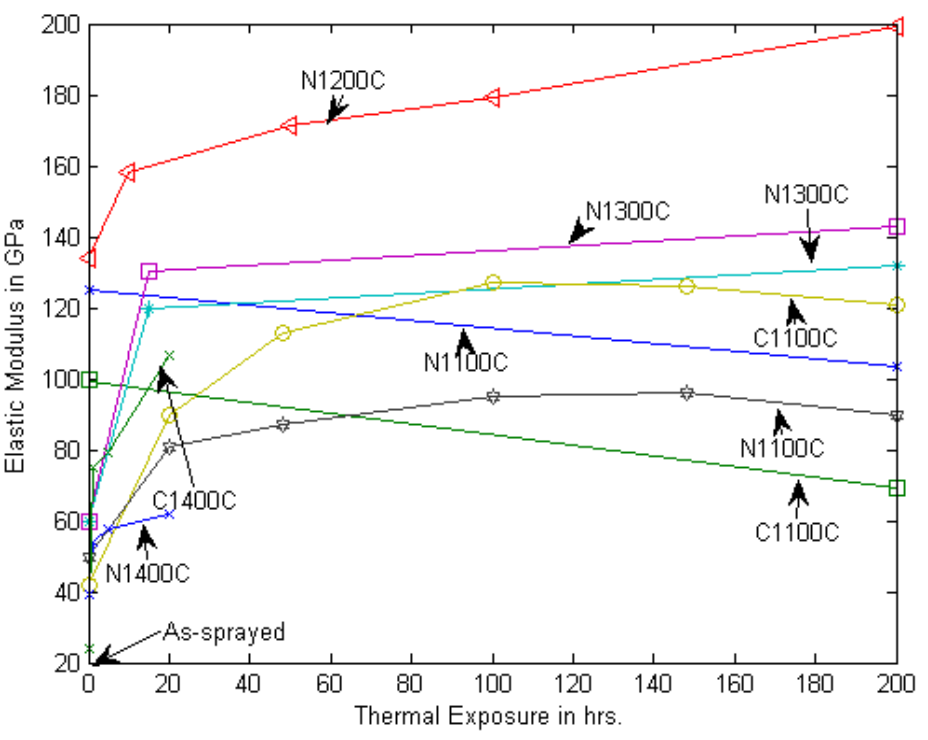
Figure 4. Elastic modulus for thermally exposed C tbc and N tbc . Data collected from published sources are plotted only up to 200 h. of sintering to highlight the trend [12,20,55,68]. N and C stand for N tbc and C tbc . The sintering temperature in °C is shown for each line. No clear trend for the sintering temperature is observed.